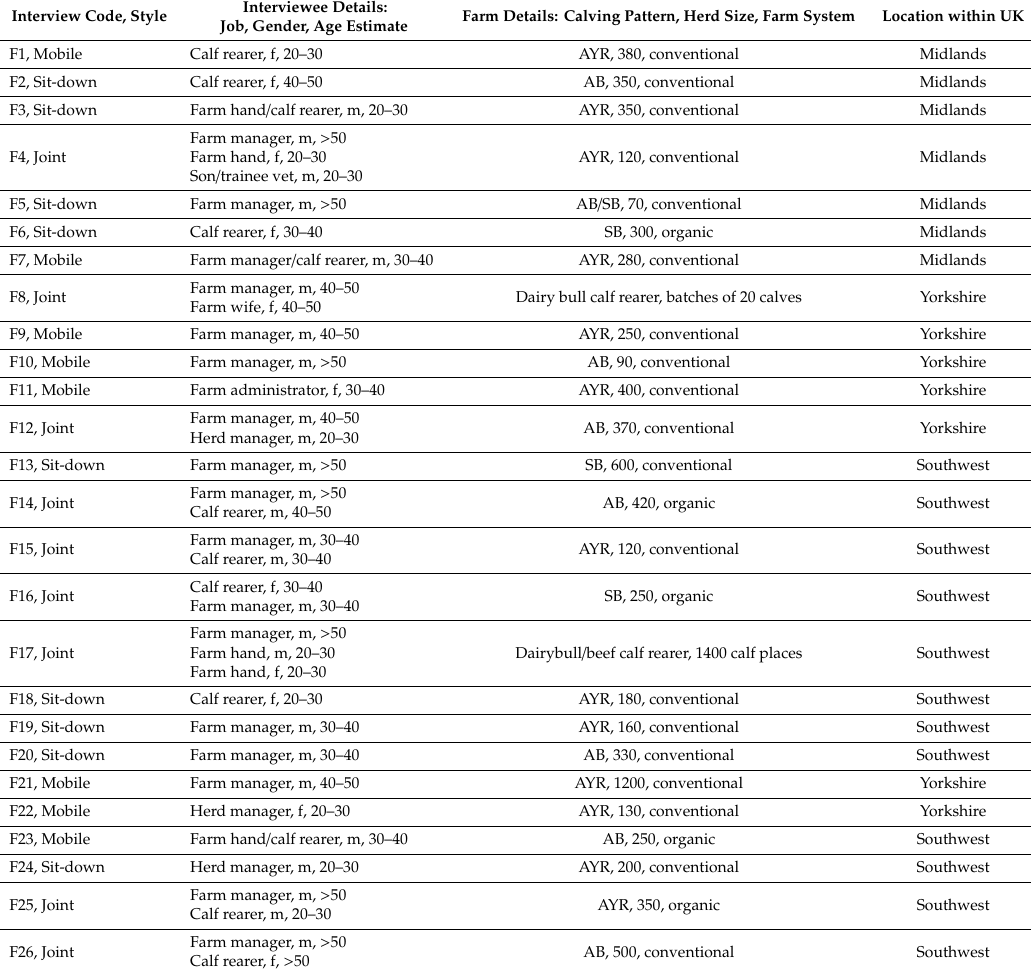
Table 1. Farmer participant demographics.